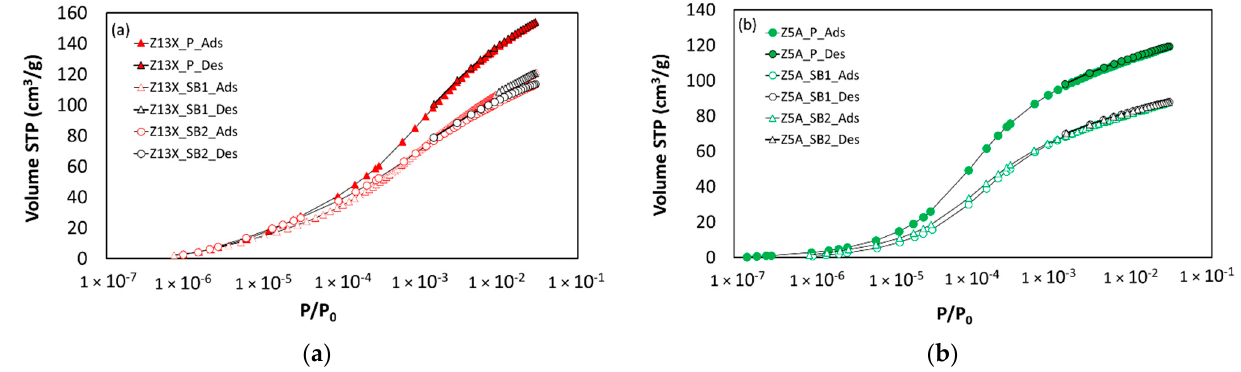
Figure 4. CO 2 adsorption–desorption isotherms at 273 K on different zeolite samples: ( a ) 13X zeolites, and ( b ) 5A zeolites.